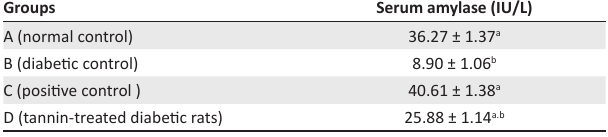
TABLE 4: Effects of tannins on serum amylase level of control and diabetic rats